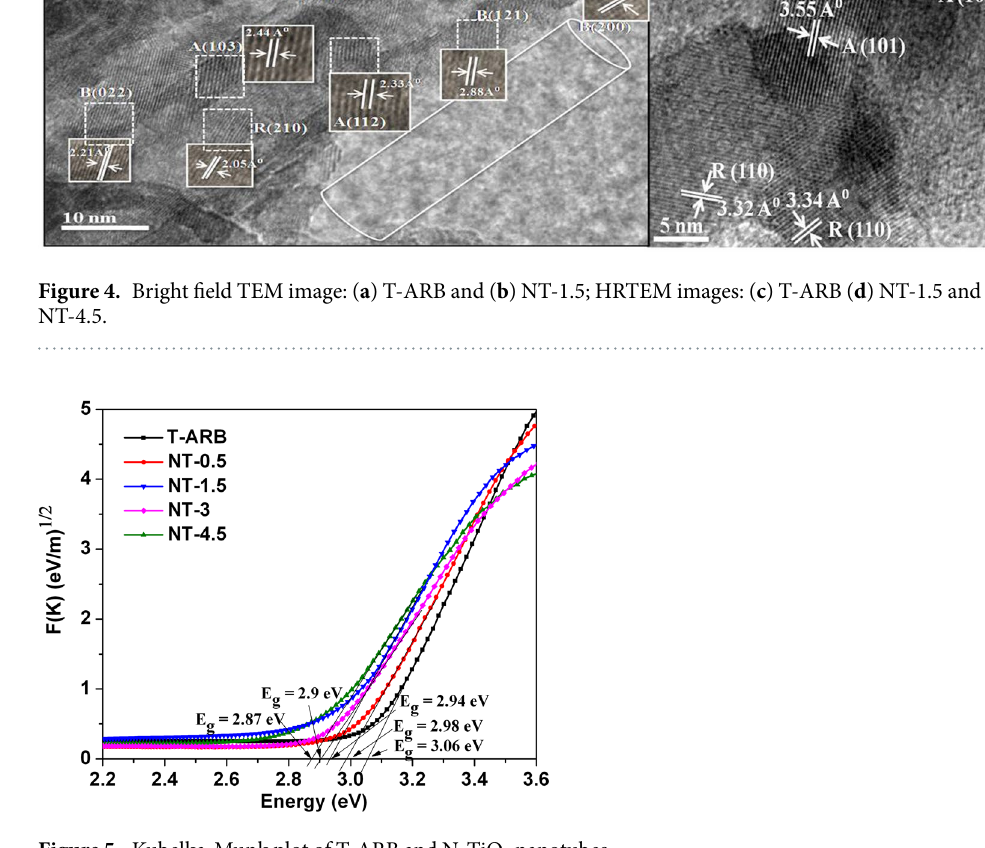
Figure 5. Kubelka-Munk plot of T-ARB and N-TiO 2